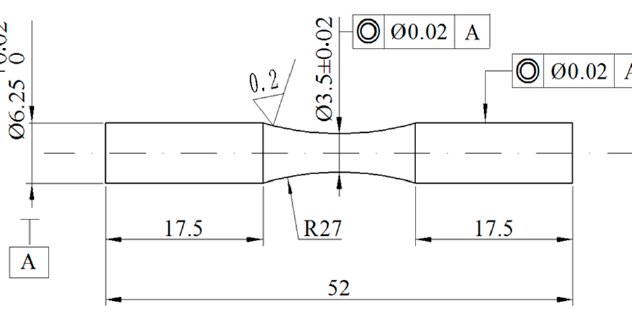
Figure 1. Geometry of fatigue test specimen (dimensions in mm).